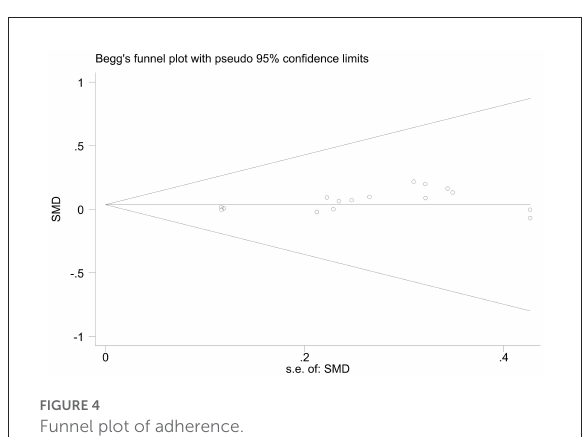
FIGURE4 Funnel plot of